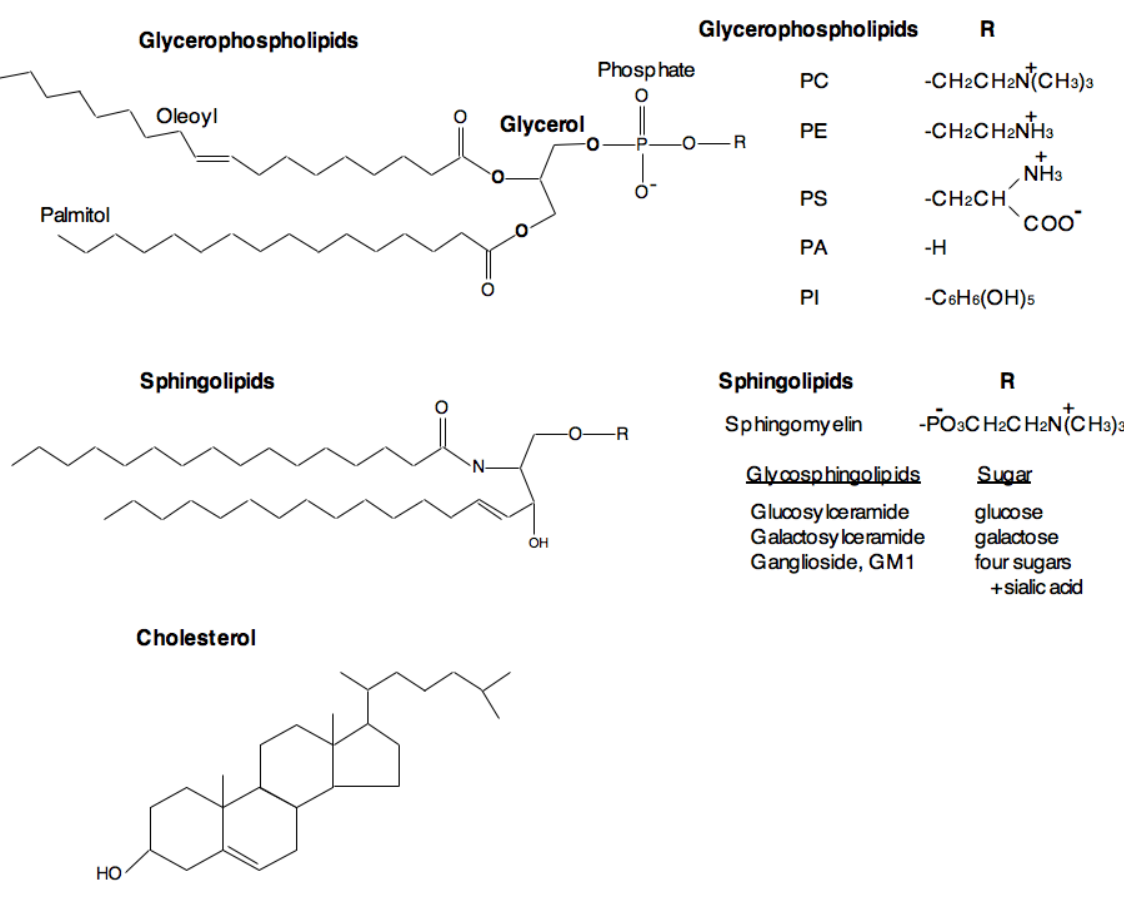
Figure 3. Structures of major classes of lipids in eukaryotic cells. Glycerophospholipids contain diacylglycerol, a phosphate group, and a simple organic head group. The acyl chains contain 16-18 carbon atoms and one of the acyl chains is generally unsaturated with a cis double bond. The head groups vary among the phospholipids; e.g., choline in phosphatidylcholine (PC), ethanolamine in phosphatidylethanolamine (PE), serine in phosphatidylserine (PS), and inositol in phosphatidylinositol (PI). Sphingolipids are based on ceramide, which has long saturated acyl chains of 16-26 carbon atoms, and either phosphorylcholine (sphingomyelin) or sugar (glycosphingolipids) headgroups. Depending on the type of sugar, glycosphingolipids are further sub-classified into several types as listed in the figure. Cholesterol is a major sterol in mammalian